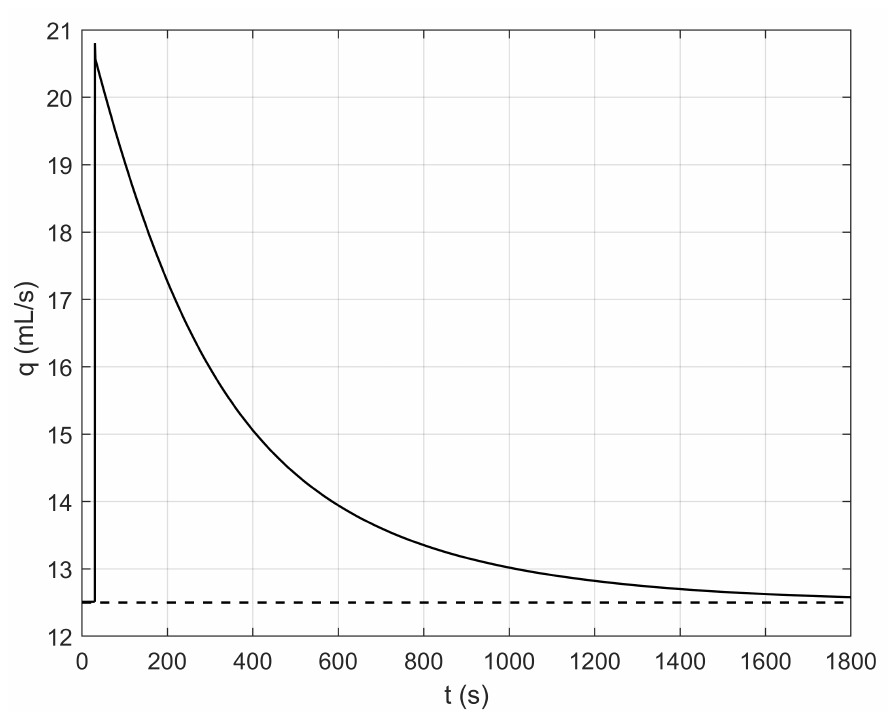
Figure 7. Arterial–arteriolar blood flow rate q autoregulation response (solid black line) to a step systemic arterial pressure increase to P a ( t ) ≡ 160 mmHg under κ 1 = 0.0026, κ 2 = 0.002, M 1 = 0.3984, M 2 = 0.001 (dashed line for the reference value q = q n